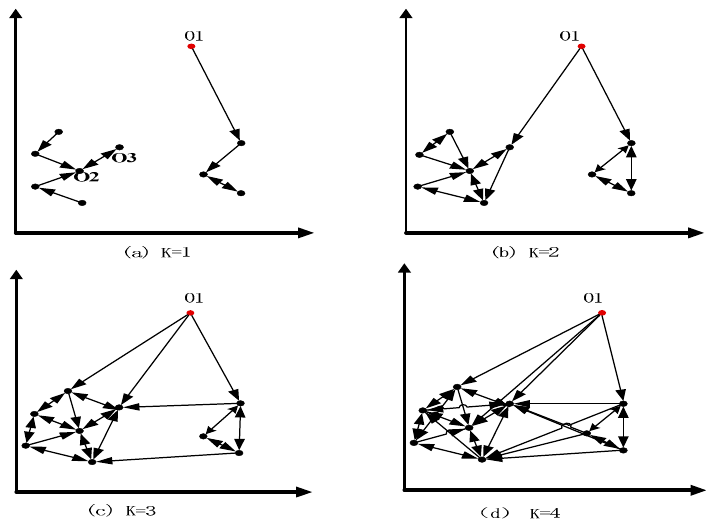
Figure 6. With the gradual increase of k, the changes of the mutual neighbor graph of the data points.